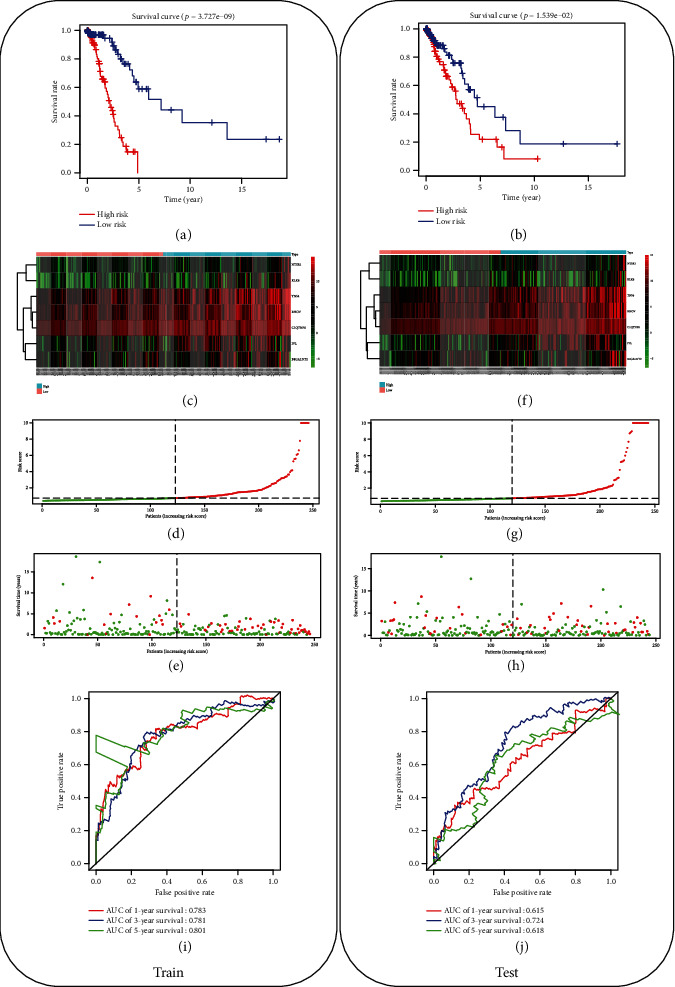
Evaluation of the 7-gene signature-based model in predicting the prognosis of LUAD patients. (a, b) The survival time between the patients of the high- and low-risk groups within the training set and testing set was analyzed by Kaplan-Meier analysis; (c–e) heat map for the 7 genes, as well as the risk score distribution and survival of patients in the training set; (f, g, h) heat map for the 7 genes, as well as the risk score distribution and survival of patients in the testing set; (i, j) ROC curves of the 7-gene signature-based model in two sets.